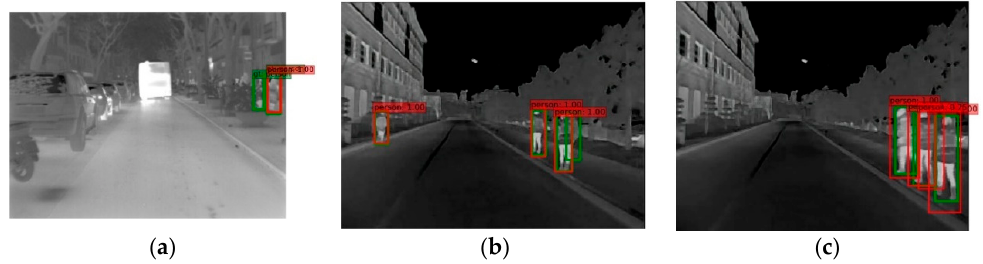
Figure 10. Failure cases of our proposed infrared (IR) pedestrian detection method. The green bounding boxes denote the ground truth. The red bounding boxes show the detection results. ( a–c ) are visualization of failure cases on the image set selected from the KMU and CVC09 datasets.